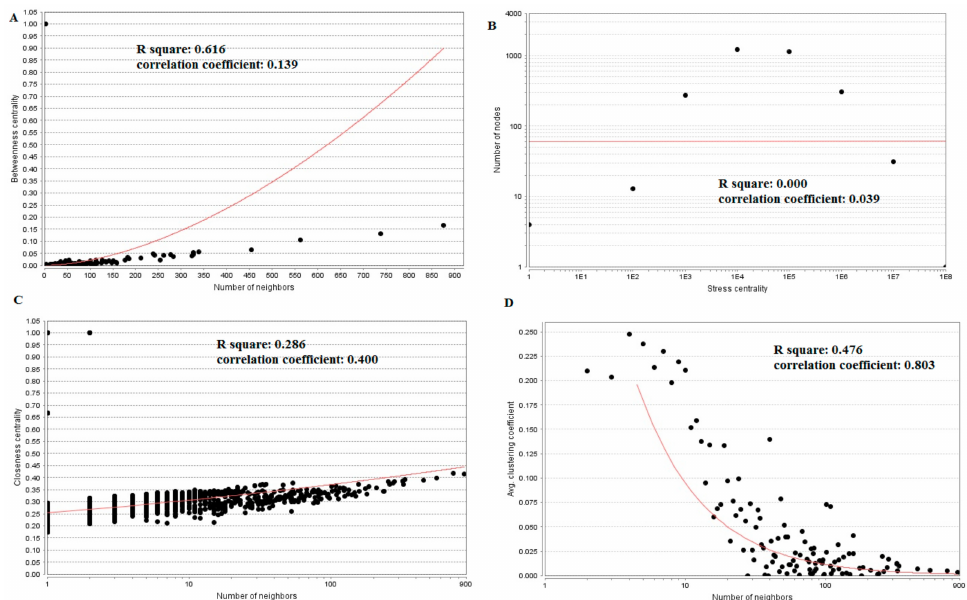
Figure 8. Regression diagrams for up-regulated genes ( A ) Betweenness centrality; ( B ) Stress centrality; ( C ) Closeness centrality; ( D ) Clustering coe ffi